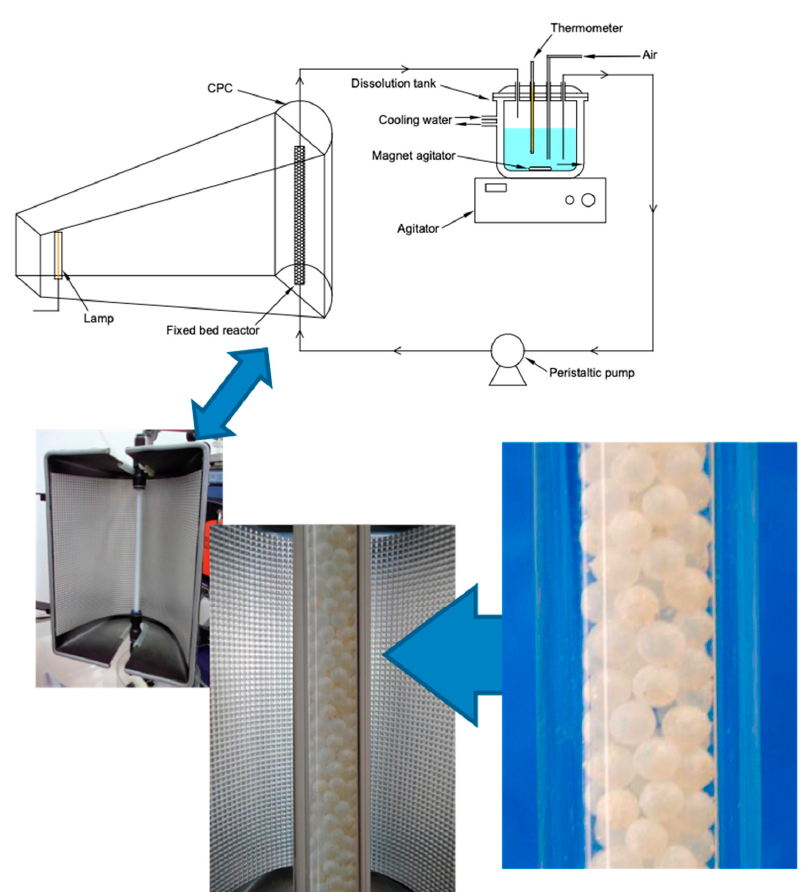
Figure 2. Packed-bed photoreactor system (with Degussa P25 TiO 2 coated glass spheres. A solar radiation sodium vapour lamp was used in this system, with a parabolic collector [13].